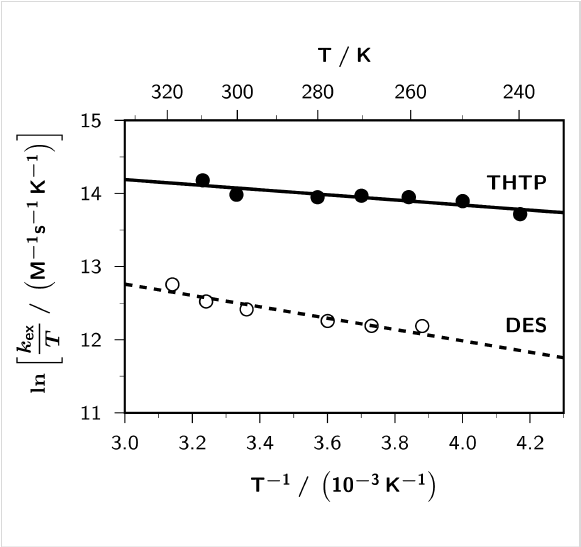
Figure 2: Eyring plots of the self-exchange rate constants k ex for DES (open circles and broken line; linear regression, 15.08 – 775/ T , r 2 = 0.94) and THTP (filled circles and solid line; linear regression, 15.24 – 349/ T , r 2 = 0.88) in acetonitrile- d 3 ; sensitizer TTP + . For all other experimental parameters and further explanation, see Figure 1 and text.